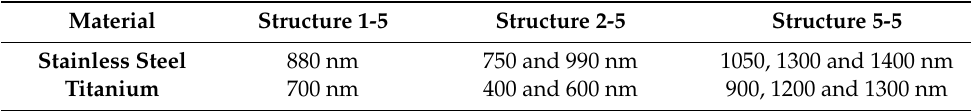
Table 4. Approximate depths of the deepest structures on steel and titanium measured by AFM. The structures 2-5 and 5-5 show multiple depths due to the multiple laser radiation in certain areas.